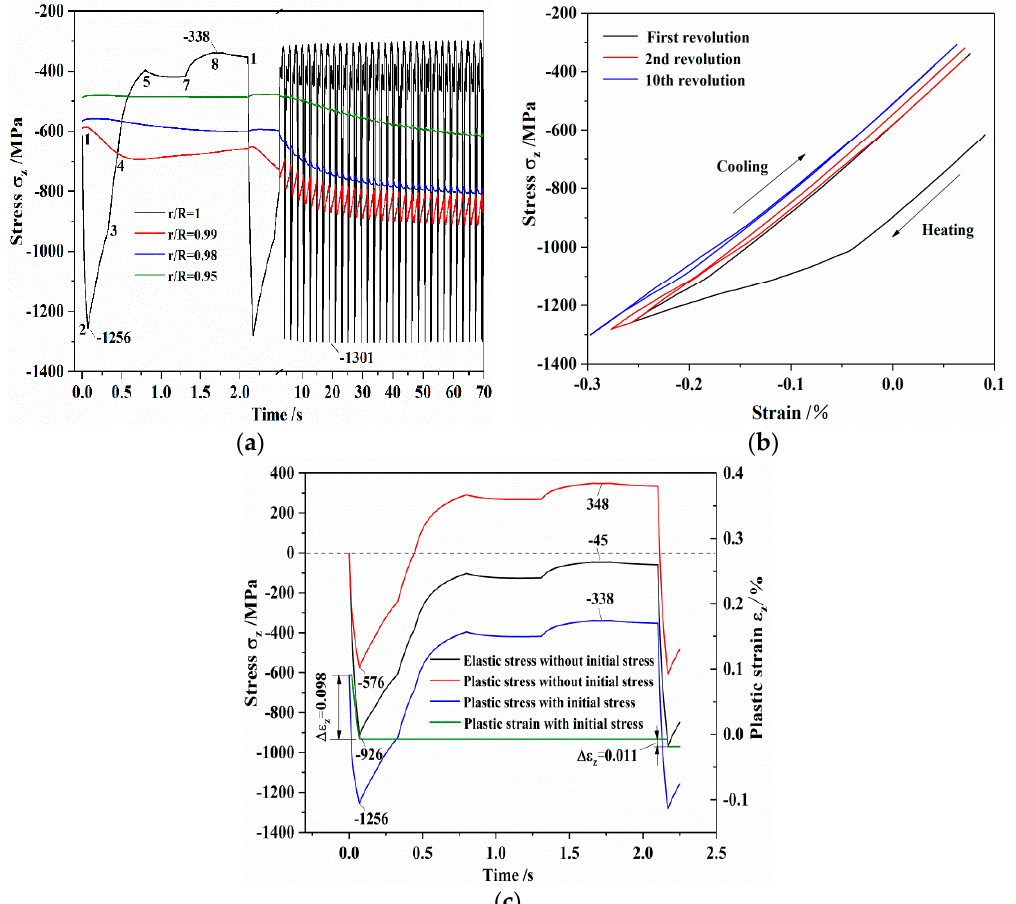
Figure 5. Thermal stress considering the initial residual stress in the HSS work roll during hot rolling: ( a ) stresses at the different depths from the roll surface; ( b ) stress-strain hysteresis loop at the surface; ( c ) comparison of the thermal stresses between with and without considering the initial residual stress .